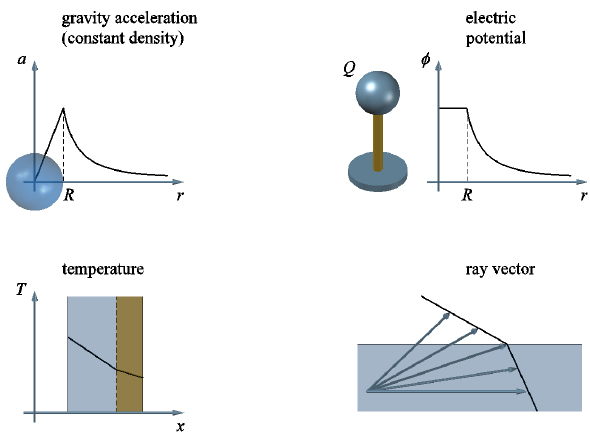
Figure 10: Continuity of the global variables associated with points in domains made of more than one medium.